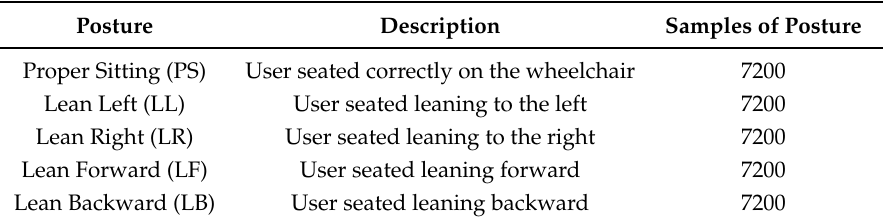
Table 5. Wheelchair user postures of